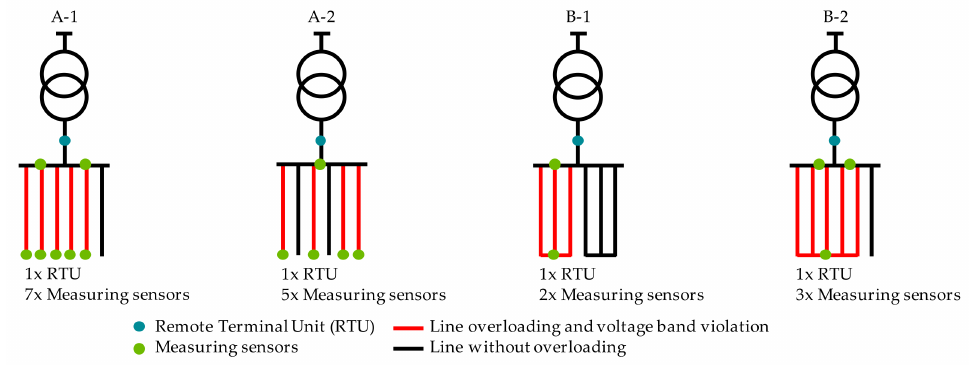
Figure 11. Examples of consideration of a grid automation system for different topologies with ( A-1 ) radial grid with five overloaded feeders, ( A-2 ) radial grid with four overloaded feeders, ( B-1 ) meshed grid with one overloaded mesh and three feeders, and ( B-2 ) meshed grid with one overloaded mesh and five